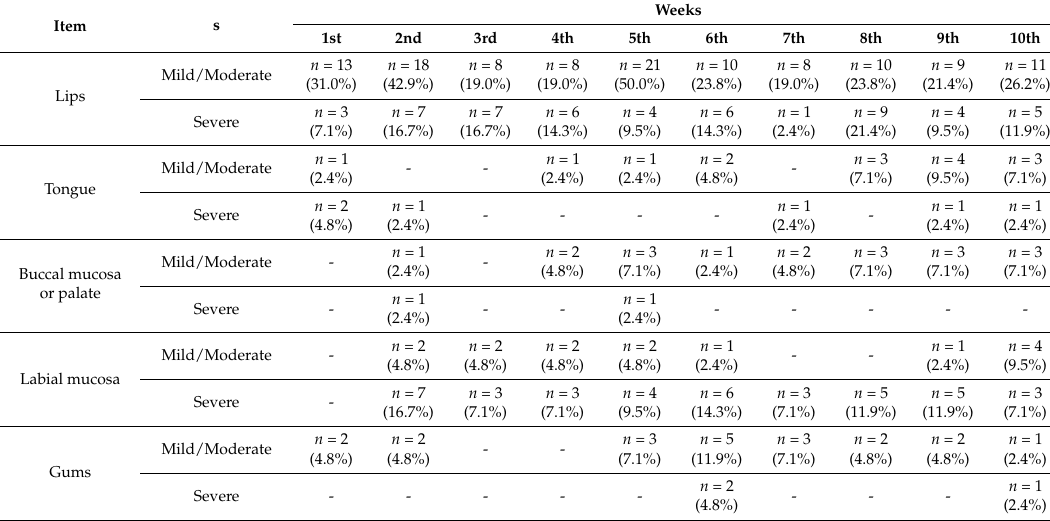
Table 4. Alteration/discomfort in oral mucosa according to the Oral Assessment Guide scores during the 10 weeks of evaluation.